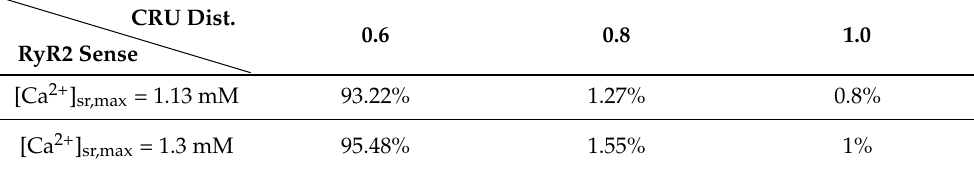
Table 1. Percentage of Ca 2+ sparks resulting in a Ca 2+